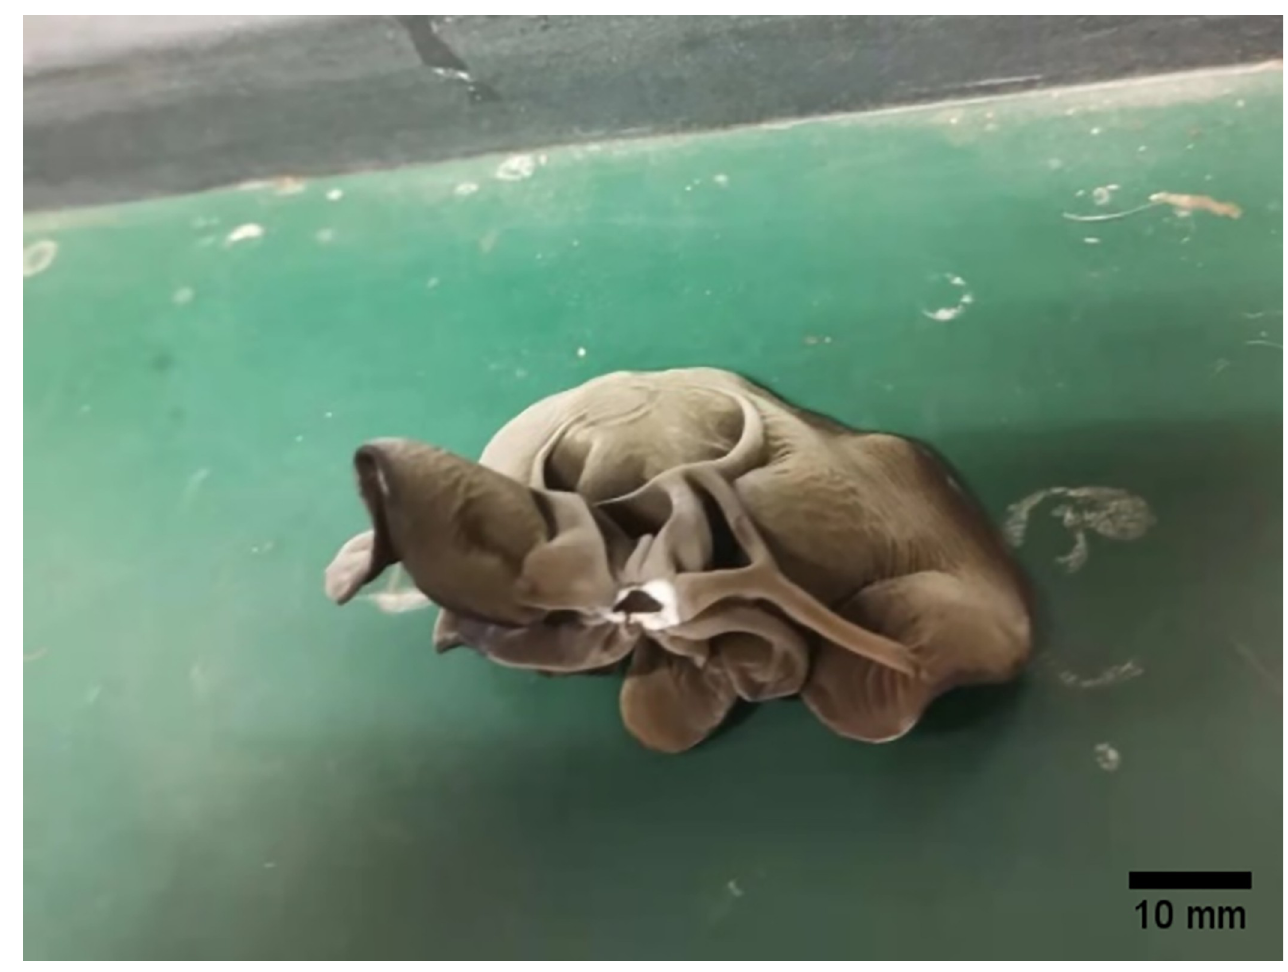
Fig 16. The over-mature black fungus.